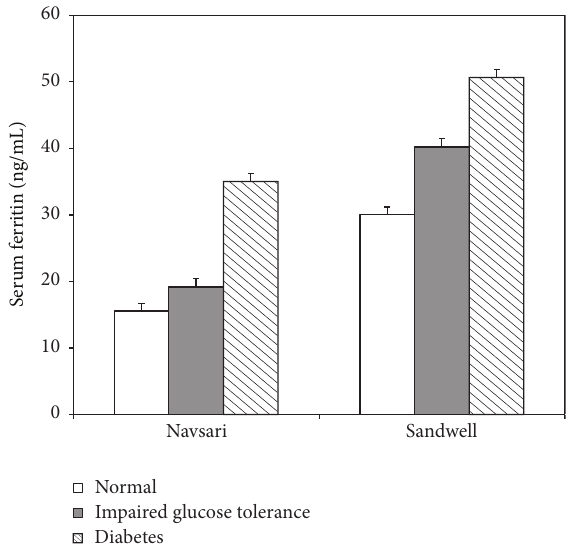
Figure 1: Serum ferritin in nonmigrant (Navsari) and migrant (Sandwell) Indian men and women by glucose tolerance status. Bars show geometric means (error bars show 1 standard